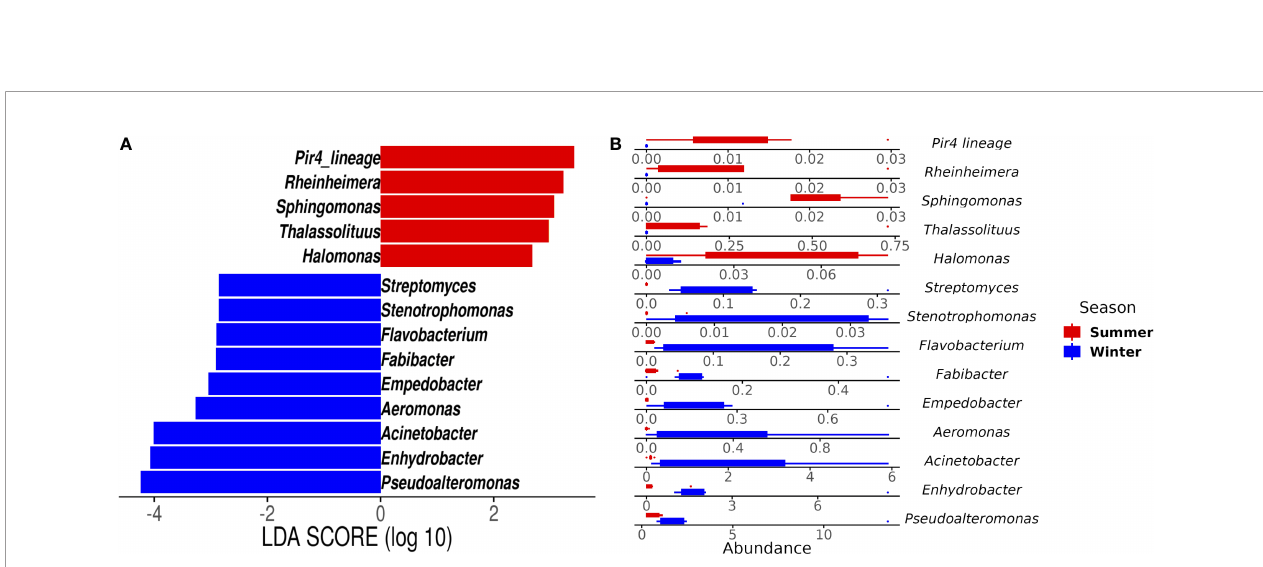
FIGURE 6 | Linear Discriminant Analysis of Effect Size (LEfSe) at the genus level by season. The analysis shows (A) genera that differed signi fi cantly in abundance in summer (red bars) and winter samples (blue bars) (LDA score > 2; p < 0.05). (B) Abundance for the genera highlighted by the LEfSe analysis for both seasons. Note the different values for the